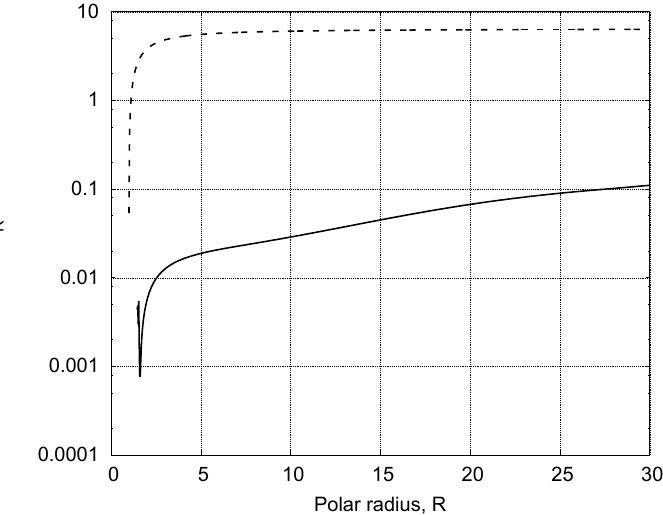
Figure 7. Dependence of the poloidal velocity on the polar radius R at the equator (solid line) and at the axis of rotation (dashed line), ω =